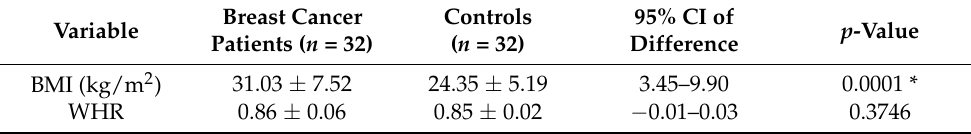
Table 2. Anthropometric data of study